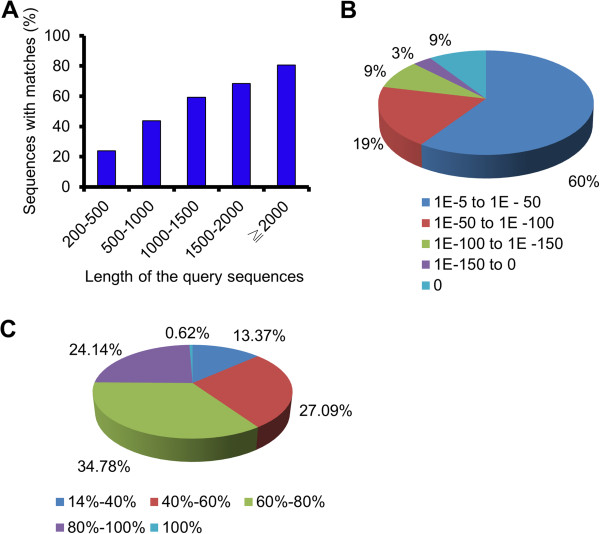
Characteristics of homology search of Illumina sequences against the nr database. (A) Effect of query sequence length on the percentage of sequences for which significant matches were found. The proportion of sequences with matches (with a cut-off E-value of 1.0E-5) in the NCBI nr databases is greater among the longer assembled sequences. (B) E-value distribution of BLAST hits against the nr database for each unique sequence with a cut-off E-value of 1.0E-5. (C) Similarity distribution of the top BLAST hits for each sequence.